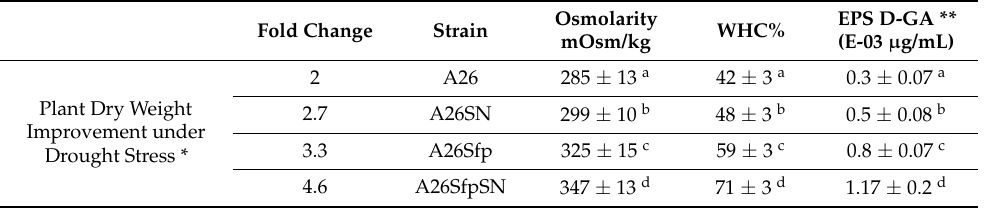
Table 4. Effect of bacterially produced biopolymers on osmotic properties and WHC. Different letters indicate statistically significant differences ( p <